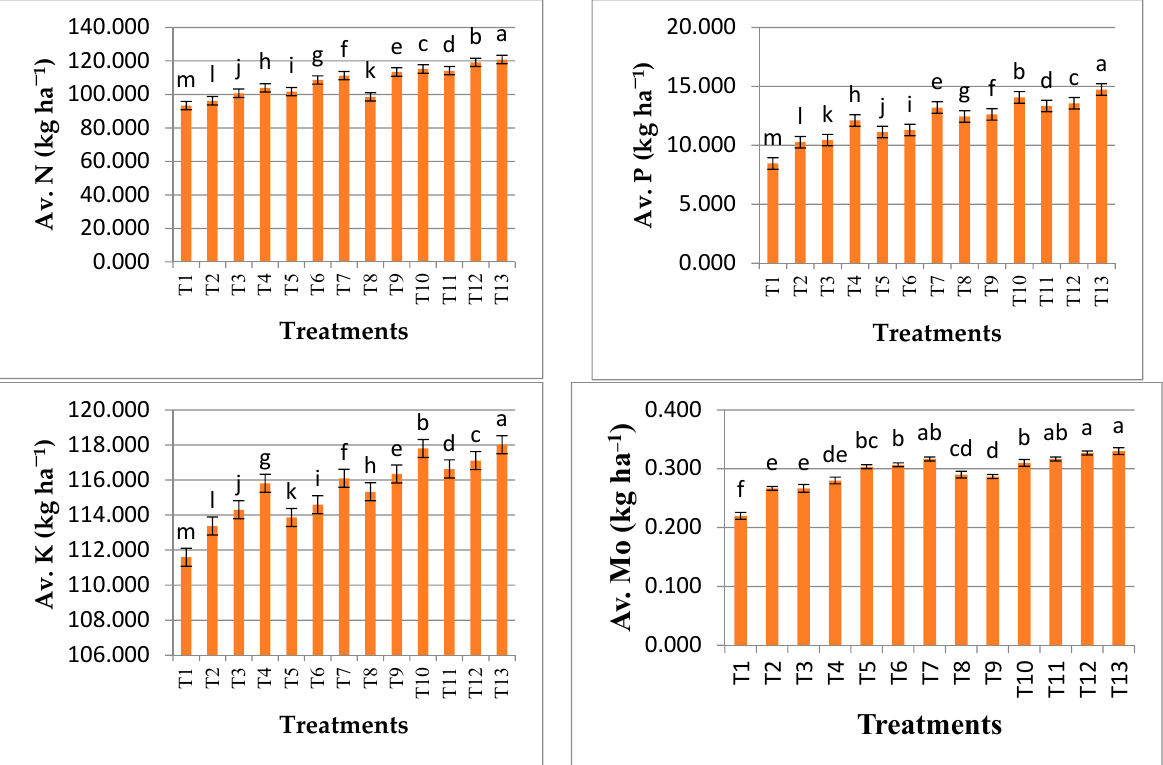
Figure 3. Effect of different treatments on soil available nutrients. Mean values with different letters differ significantly ( p < 0.05) .